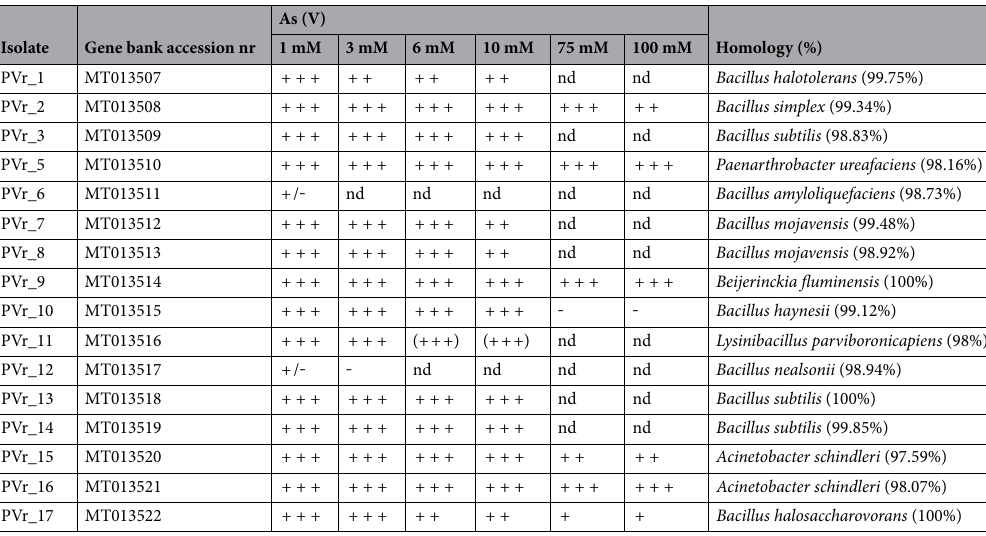
Table 2. Characterization of bacterial isolates from Pteris vittata roots and their resistance to increasing As (V) concentrations. PVr = Pteris vittata root. Bacterial growth (visual evaluation) after 24 to 48 h in PCA plates at increasing As(V) concentration: ‐ absence; + ‐ slight; + moderate; + + medium; + + + high (compared to unpolluted controls) nd = not determined.